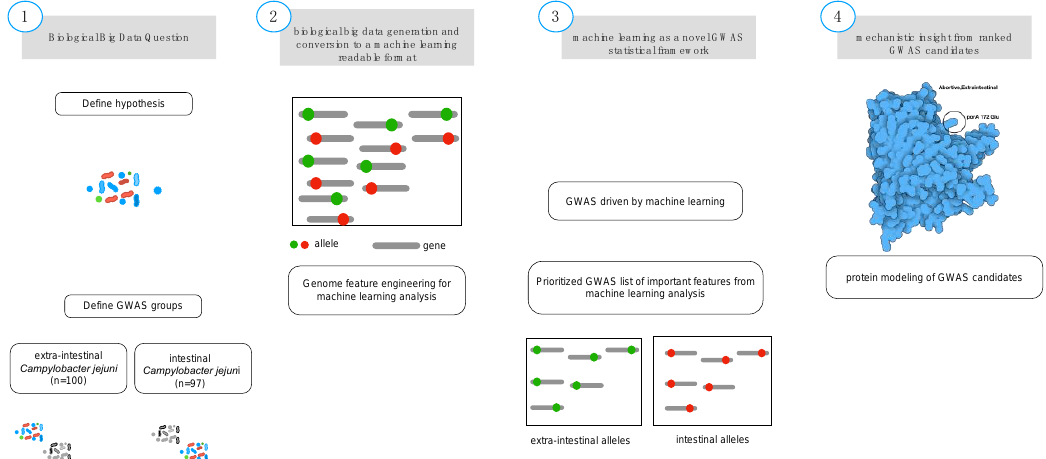
Figure 1. Biological feature engineering of genomic data for machine learning analysis. A critical step in feature engineering is selection of the appropriate comparison groups to enable classification of alleles that are related to the specific phenotype of interest (i.e., intestinal (controls; diarrheal; n = 108) and extraintestinal (cases; abortive; n = 85) (Step 1). Population-wide allelic variants (red dot = intestinal, green dot = extraintestinal) that result from variant calling (Step 2) and are used as the input features for machine learning analysis (Step 3). The predicted model generated from the machine learning analysis is inspected for the most predictive features using biological context, input, and protein modeling (Step 4) that represents a non-synonymous mutation from the genomic population of allelic variants ( n = 193).